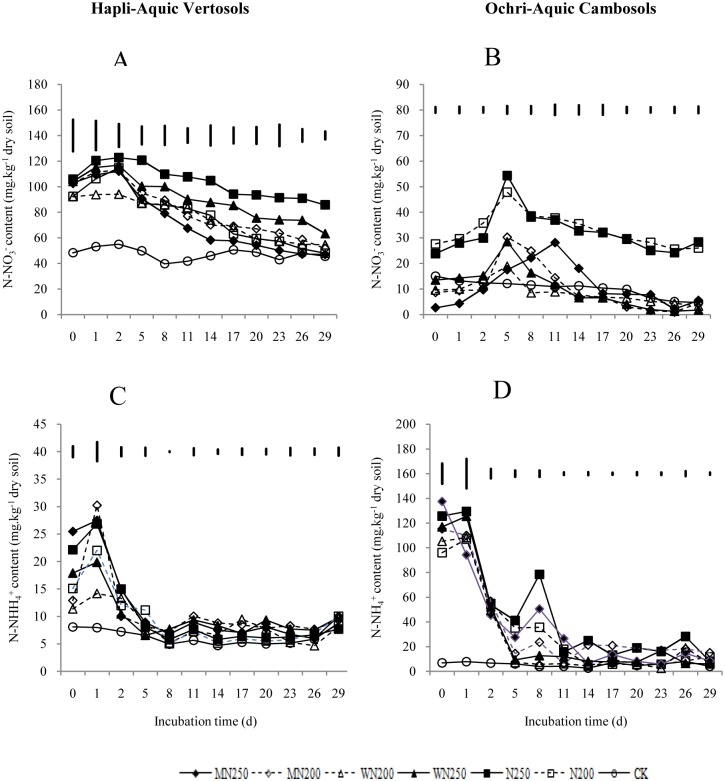
Dynamics of nitrate nitrogen (A, B) and ammonium nitrogen (C, D) contents in the Hapli-Aquic Vertosols and the Ochri-Aquic Cambosols soils.The vertical bars represent LSD0.05.